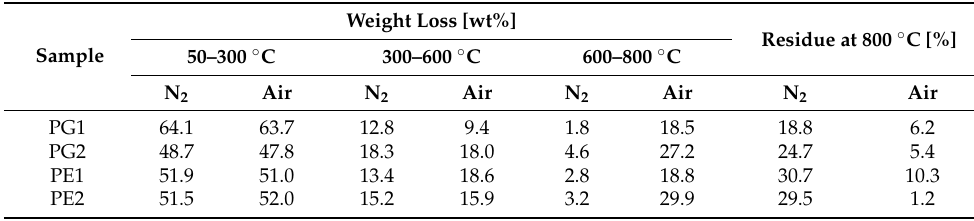
Table 3. Data obtained from TGA results.